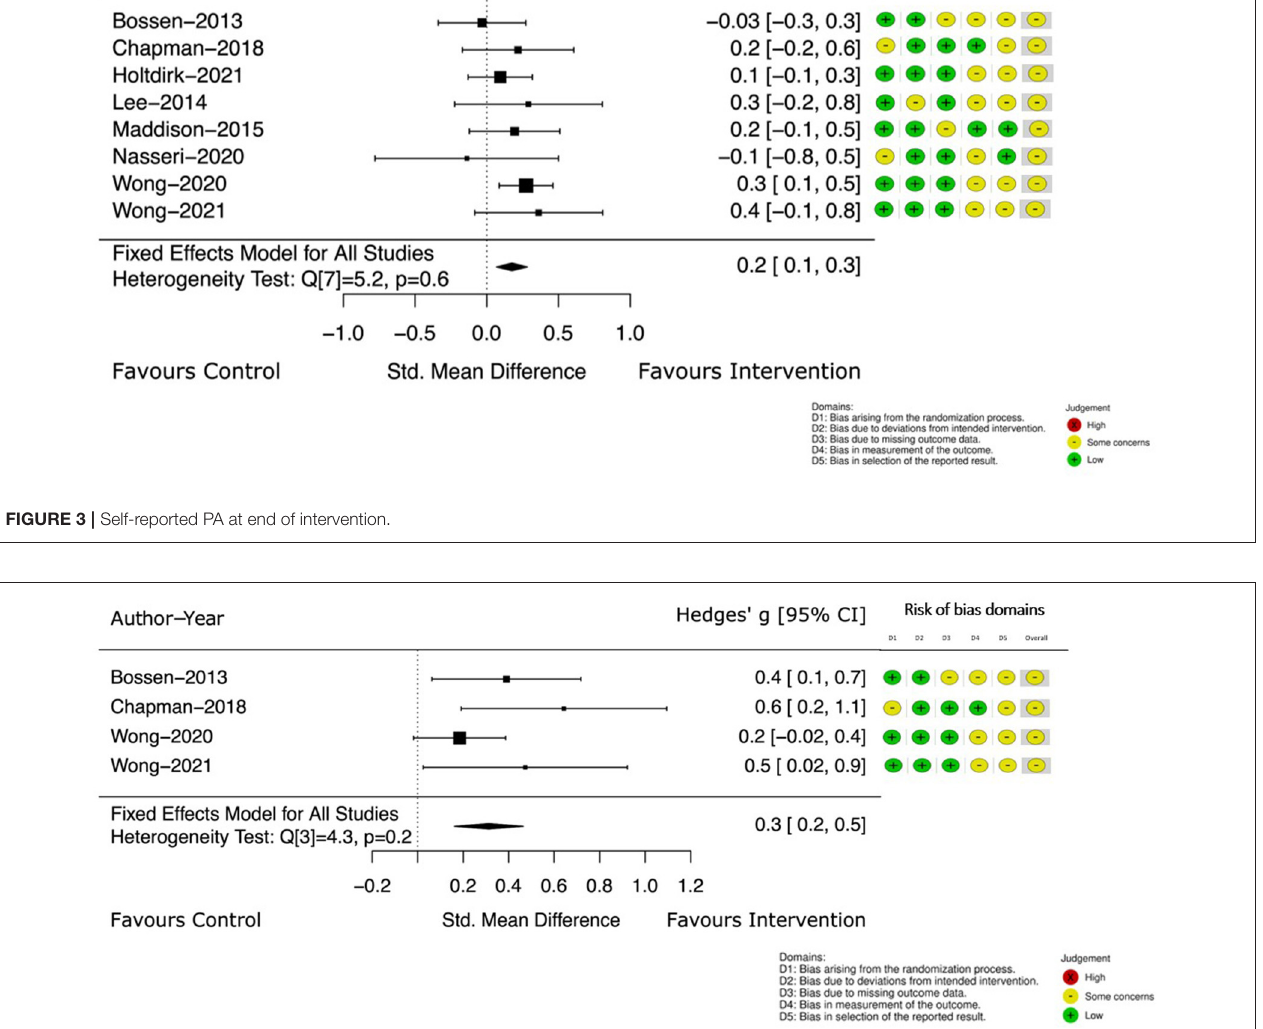
FIGURE 4 | Self-reported PA at follow